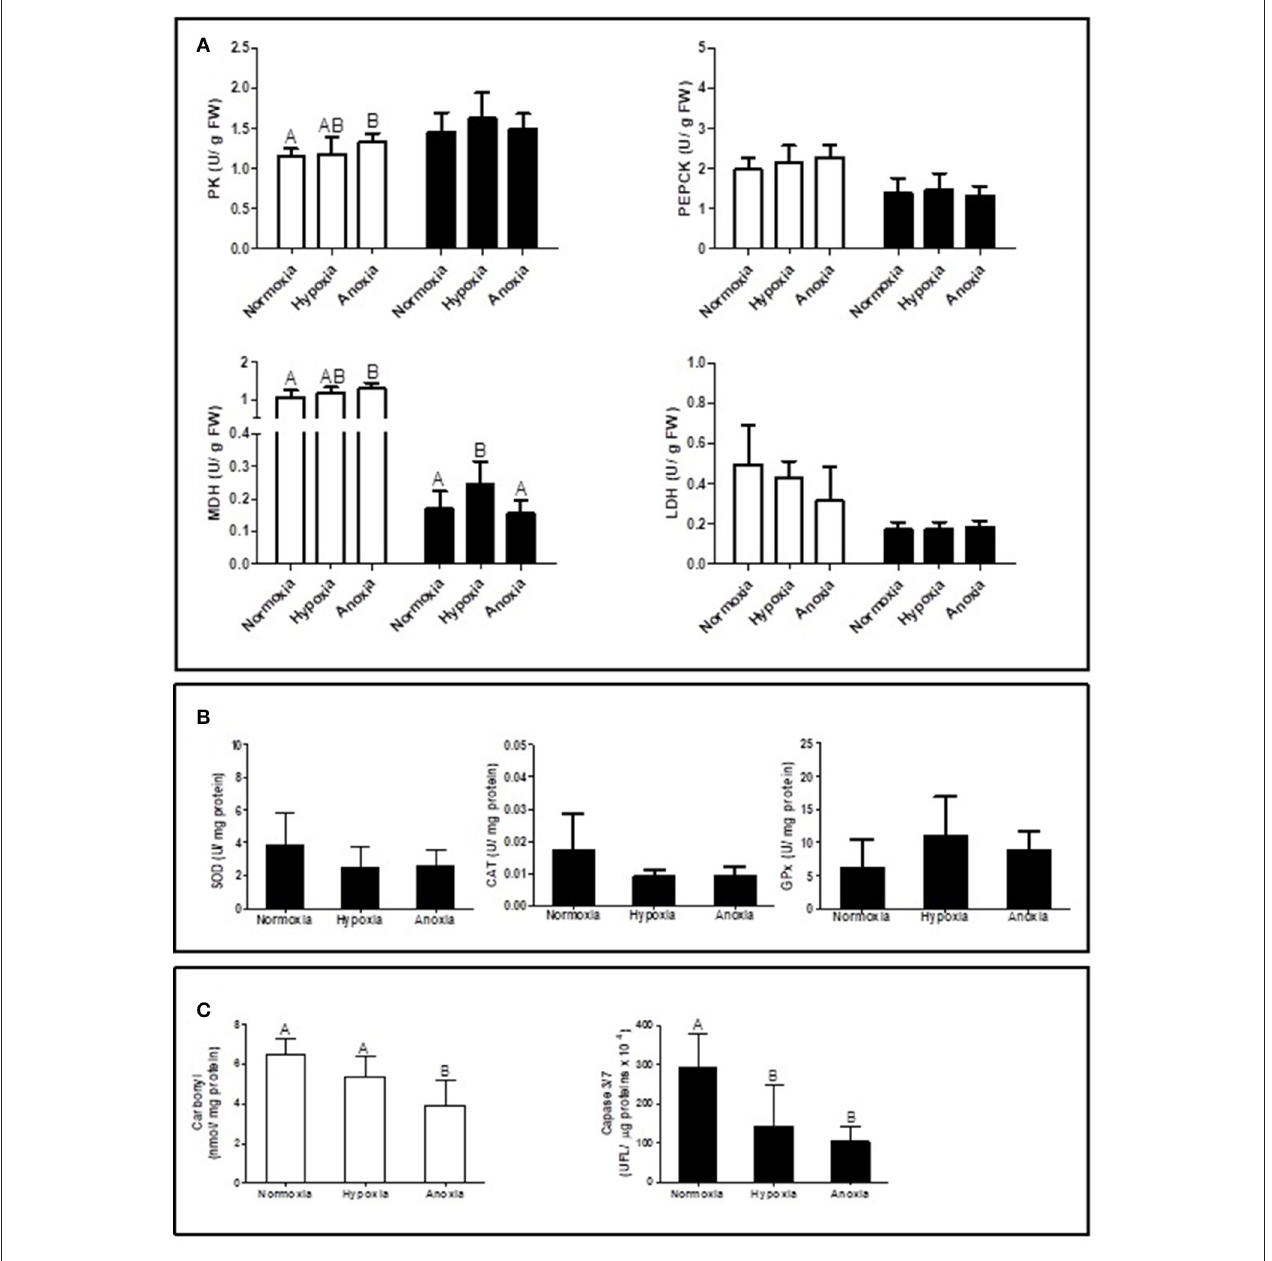
FIGURE 2 | Enzyme activities of (A) PK (pyruvate kinase), PEPCK (phosphoenol-pyruvate-carboxykinase), MDH (malate dehydrogenase), LDH (lactate dehydrogenase) in gill (white bars) and mantle (black bars), (B) SOD (superoxide dismutase), CAT (catalase), and GPx (glutathione peroxidase) in mantle; and (C) carbonyl levels in gill and caspase 3/7 activity in mantle of Diplodon chilensis exposed to anoxia ( < 0.2mg O 2 /L), hypoxia (2mg O 2 /L), and normoxia (9mg O 2 /L, control group). Different letters indicate significant differences ( p < 0.05) (means ± SD).